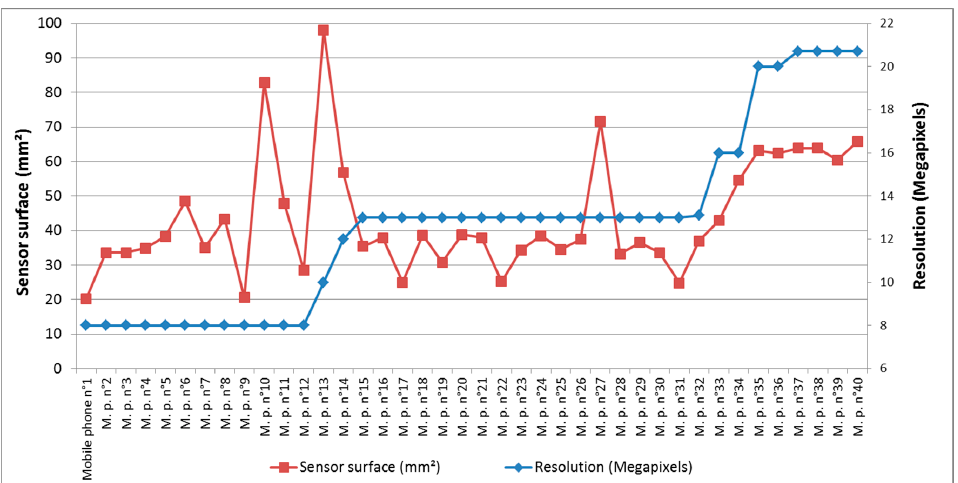
Figure 5. Relationship between camera resolution and sensor surface.